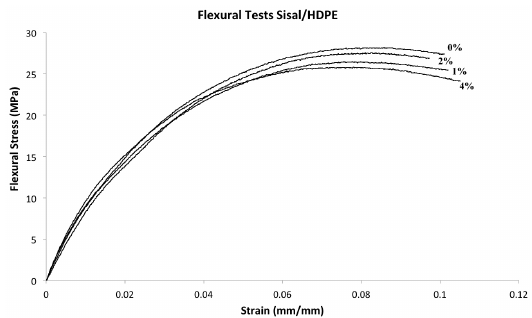
Figure 8. Flexural stress-strain average curves of HDPE/Sisal composites with different fiber percentages.